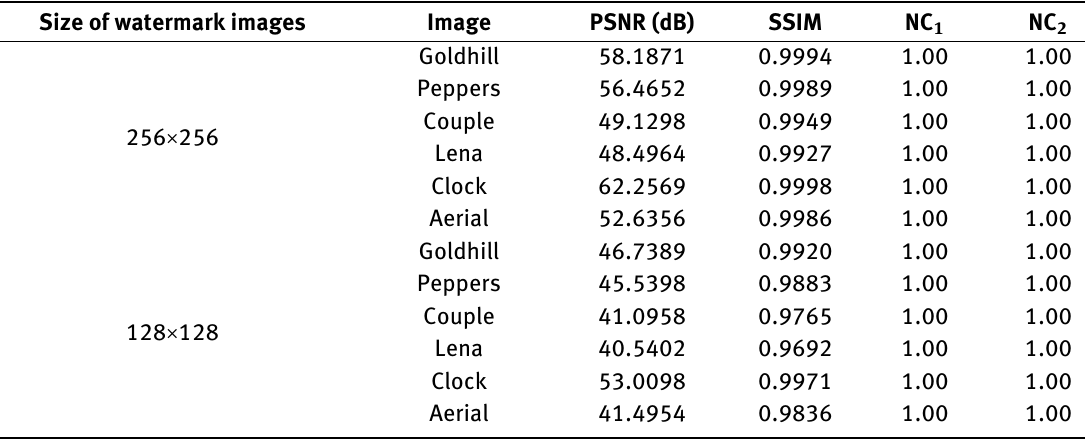
Table 2: Measuring Performance of the proposed technique Under Various Sizes of